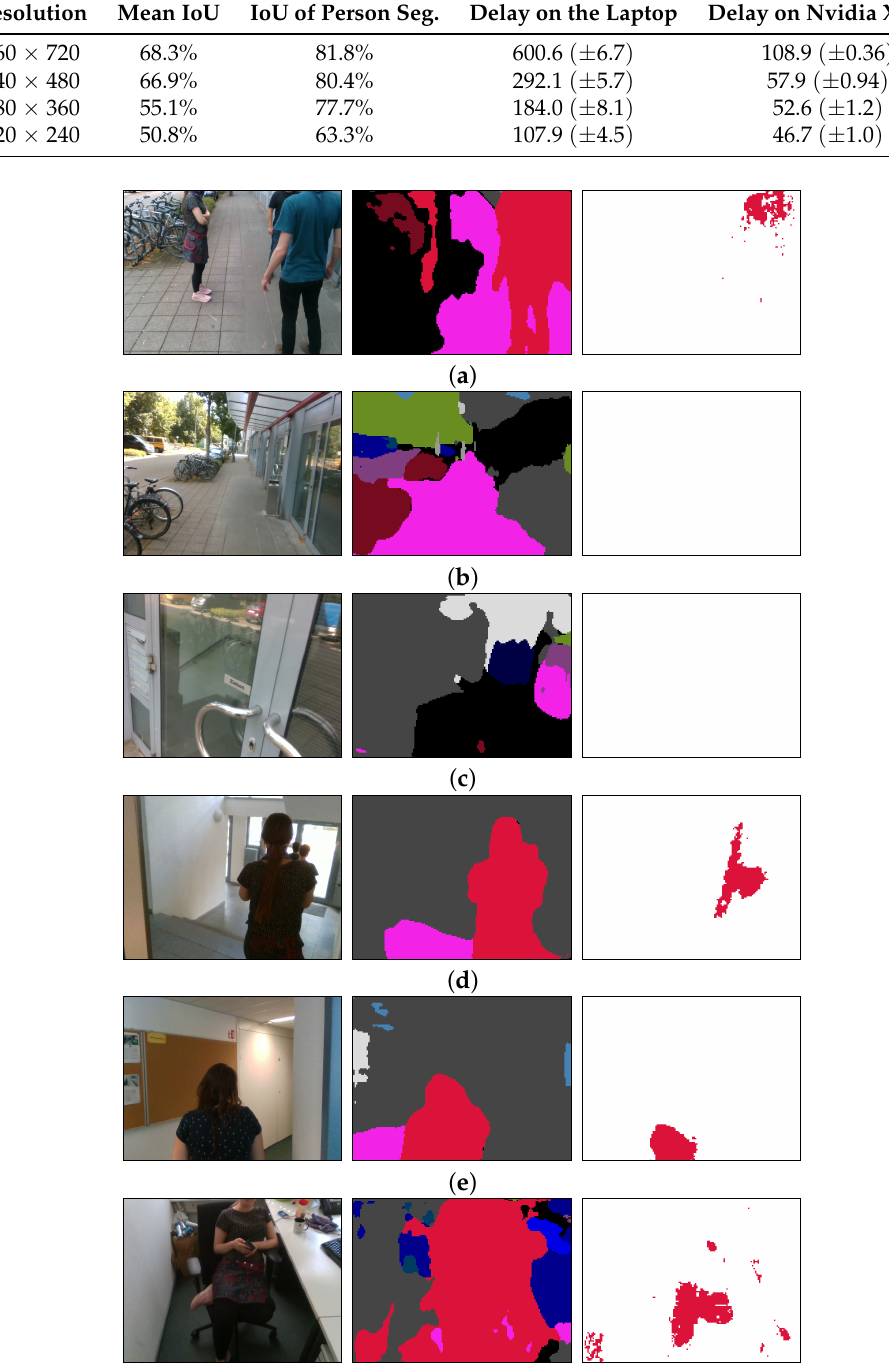
Table 2. Real-world segmentation accuracy (in mean intersection over union (IoU)) on the PASS dataset [51] and delay analysis (in milliseconds per frame).